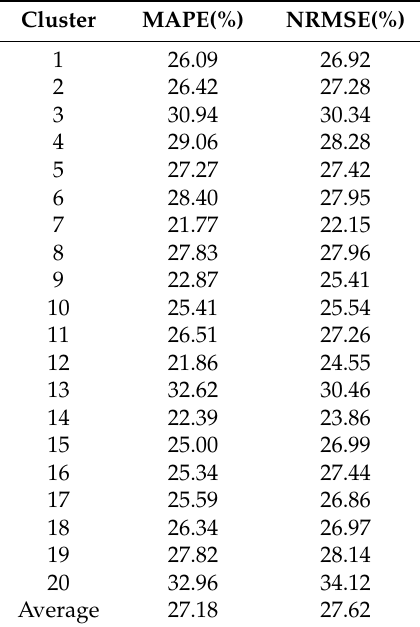
MAPE: mean absolute percentage error; NRMSE: normalized root mean square error.